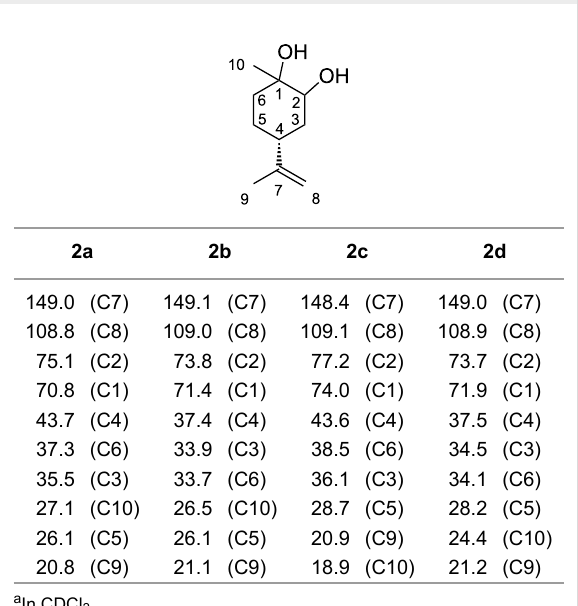
neighbouring proton b. Conversely, for 1d , the proton locates at the equatorial position; thus, the interaction with proton b is weak. These interactions support the structures shown in Figure 5. For 1b , two oxygen atoms located at the equatorial positions form a 5CC cyclic structure; then, the isopropenyl group is located at the axial position. This speculation is also as shown in Scheme 3 and Scheme